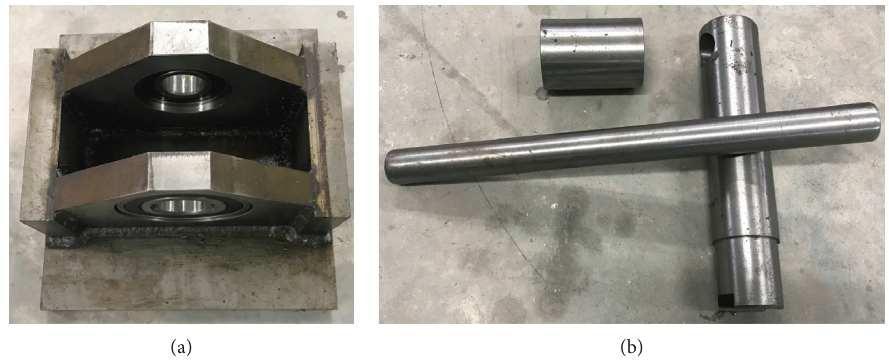
Figure 7: Holder consists of a (a) bearing support and (b) crank handle.